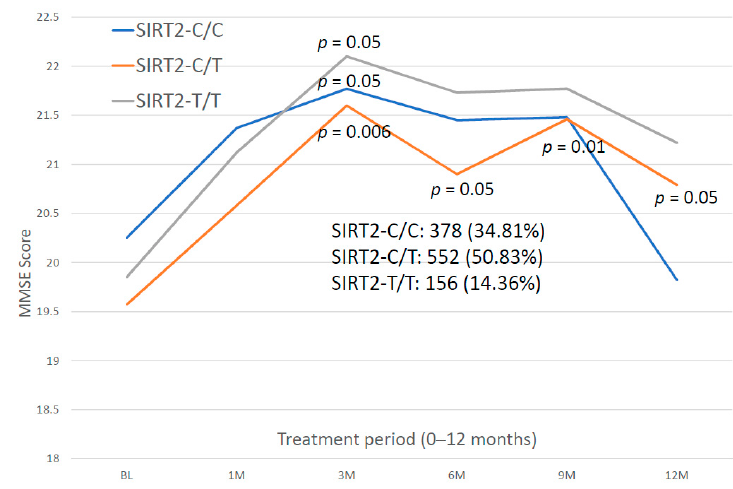
Figure 15. SIRT2 -related therapeutic response to a multifactorial treatment in Alzheimer’s disease.